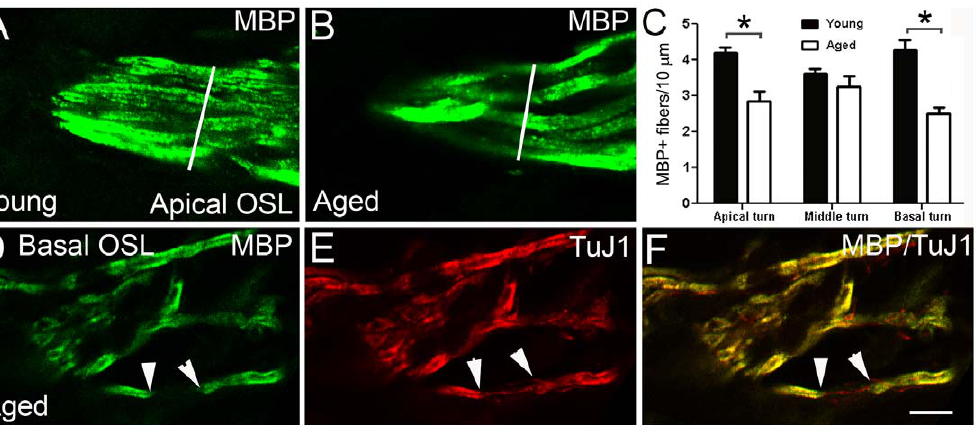
Figure 5. Age-related degeneration of MBP + nerve fibers in aged CBA/CaJ mice. A, B: Confocal images of the MBP + nerve fibers in the osseous spiral lamina of a one-month-old ( A ) and a 26-month-old ( B ) mouse. White lines indicate the areas where MBP + fibers were counted (please see Materials and Methods for detailed information on MBP + fiber counting). C: Mean density of MBP + fibers within osseous spiral lamina of the apical, middle, and basal turns from young and aged mouse ears (n=3–5 per group). A significant age-related reduction of MBP + fiber density was found within the apical and basal turn ( P , 0.05; asterisk). D, E, F: Degeneration of MBP + myelin in the auditory nerve of a 26-month-old mouse. Dual labeling with anti-MBP (green) and anti-class III b -tubulin (TuJ1, red) indicates that partial demyelination (white arrowheads) occurs in the nerve fibers within the OSL. Scale bar, 8 m m in F (applies to A–F ).